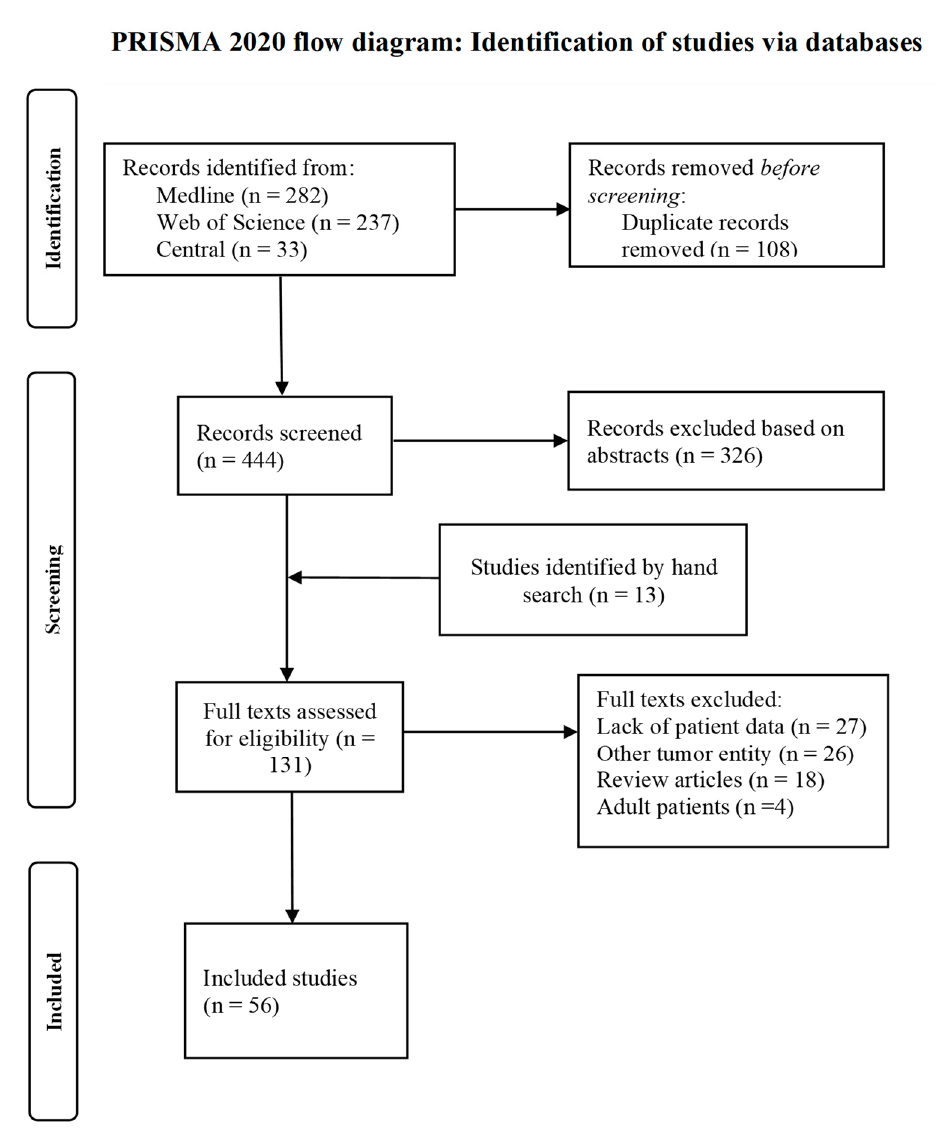
Figure 1. Prisma flow chart of study selection process.